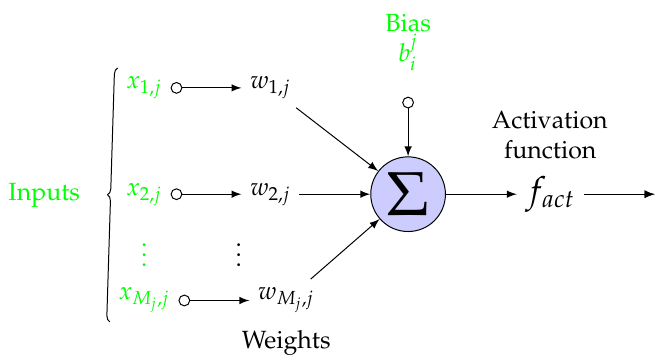
Figure 2. Structure of a single artificial neuron in a neural